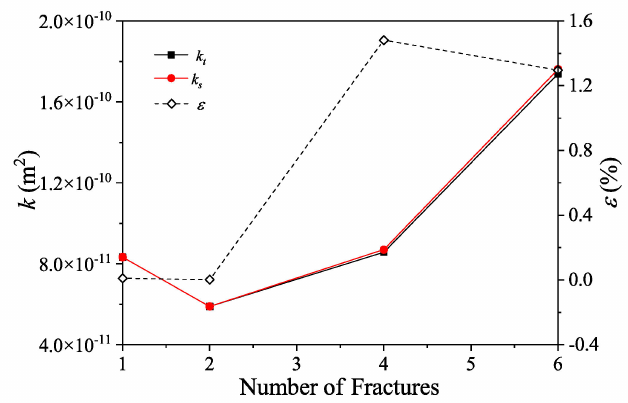
Figure 4. Comparisons of k calculated using the EPN models and the simplified DFN models, and the variations in ε versus number of